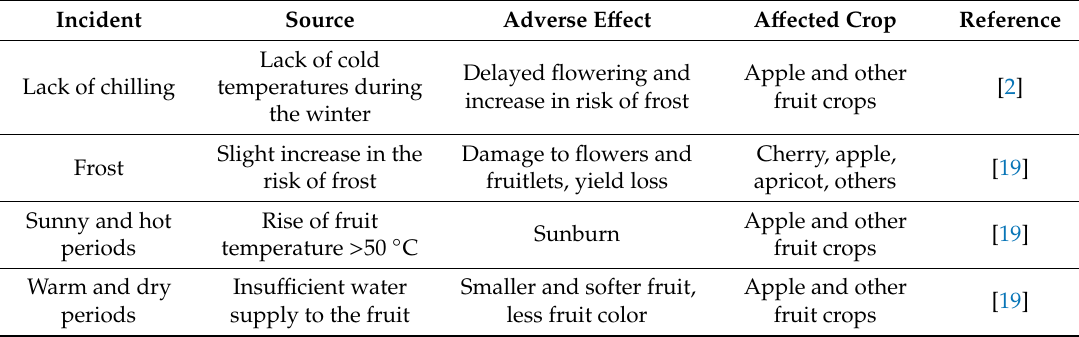
Table 2. Examples of adverse climate change e ff ects on